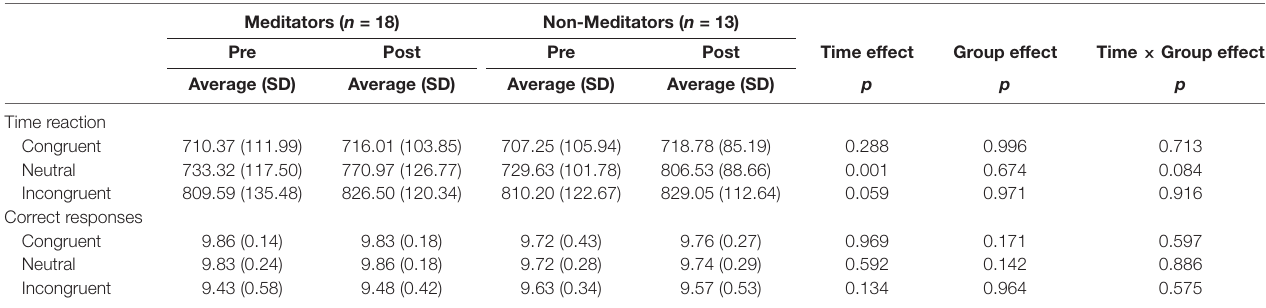
TABLE 2 | Stroop task time reaction and correct